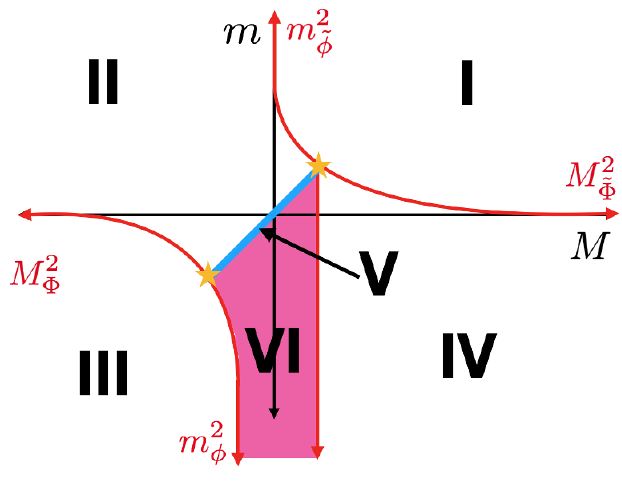
Figure 7 . Phase diagram for (cid:13)avor broken QCD 3 with f = k; F > k . These phases are laid out in section